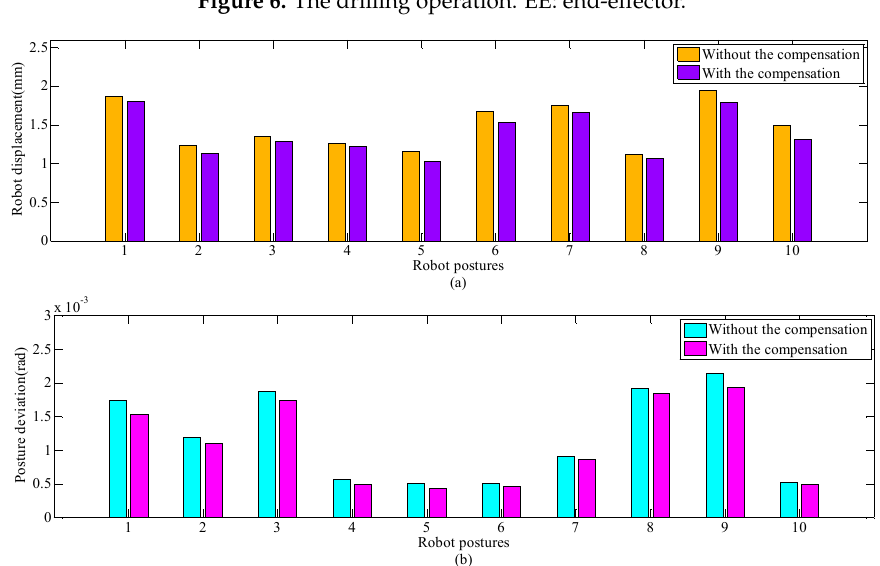
Figure 7. The pose deviation of R1. (a) With the compensation; (b) Without the compensation.